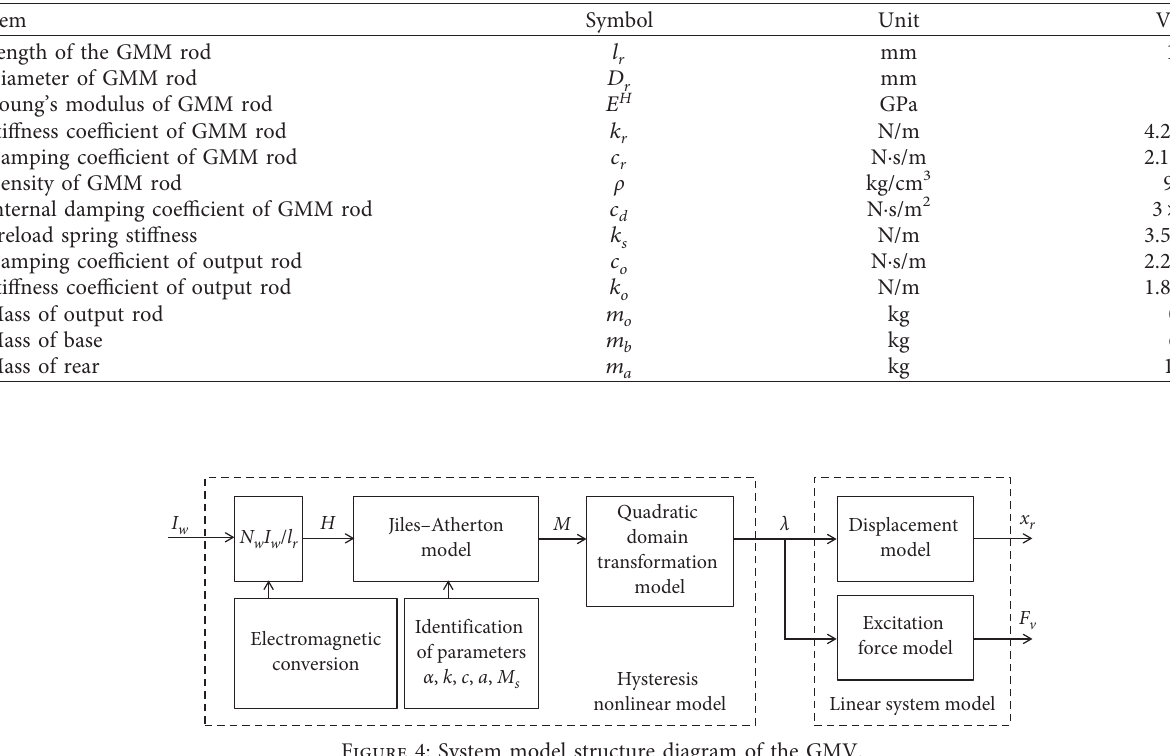
Table 1: Main structural parameters of the GMV.